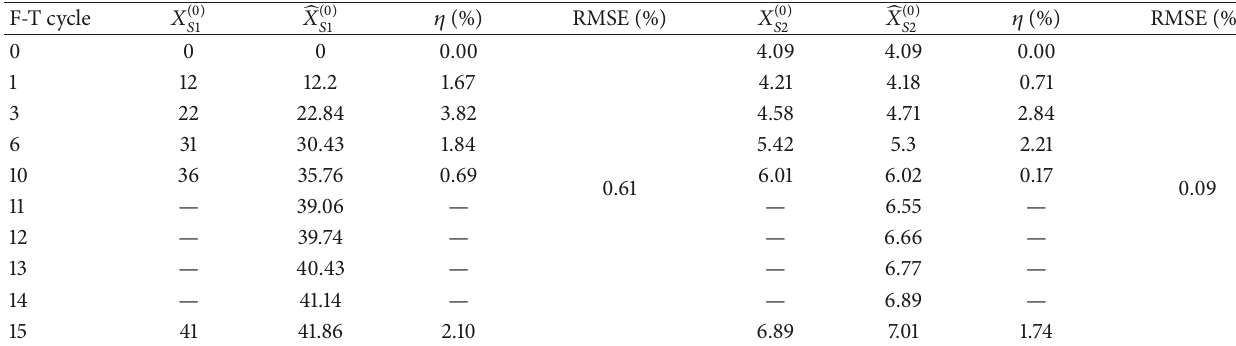
Table 15: Prediction results of 𝑋 (0) 𝑆1 and 𝑋 (0) 𝑆2 for CRSSMA based on MGM (1, 2). F-T